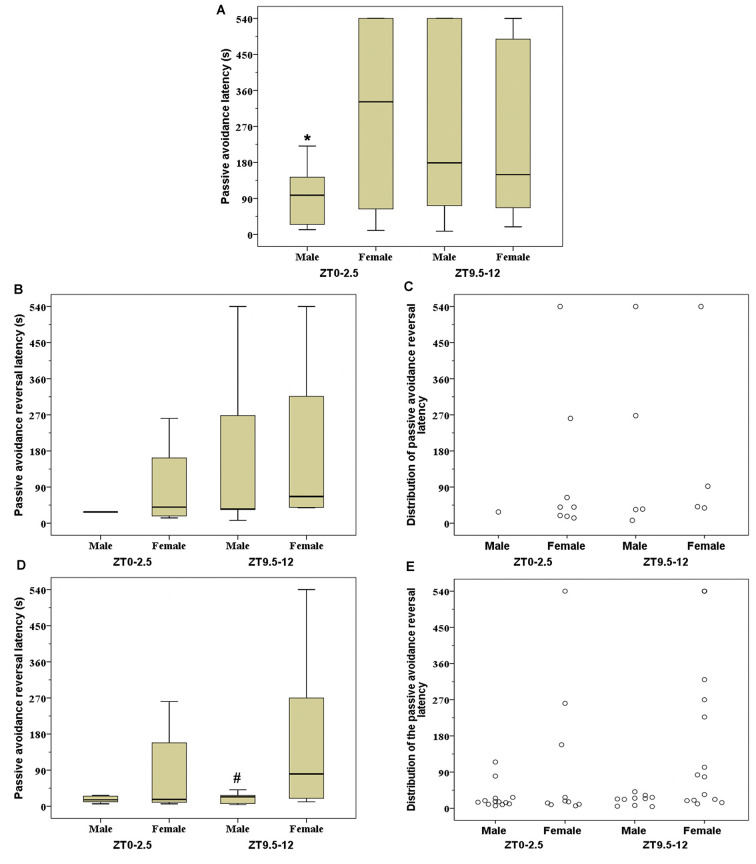
Passive avoidance (PA) latency (A), PA reversal latency (B), and individual distribution of PA reversal latency (C) in good performance mice (mice that did not enter into the dark compartment during 540 s on 24 h retention trial); PA reversal latency (D) and individual distribution of PA reversal latency (E) in mice that entered into dark compartment on 24 h retention trial. Box-and-whisker plot showing median (horizontal line inside box), 25 and 75 percentiles (edge of box) and 10 and 90 percentiles (whiskers). *p < 0.05 vs. female mice at Zeitgeber time (ZT) ZT0–2.5 and #p < 0.05 vs. female mice at ZT9.5–12.